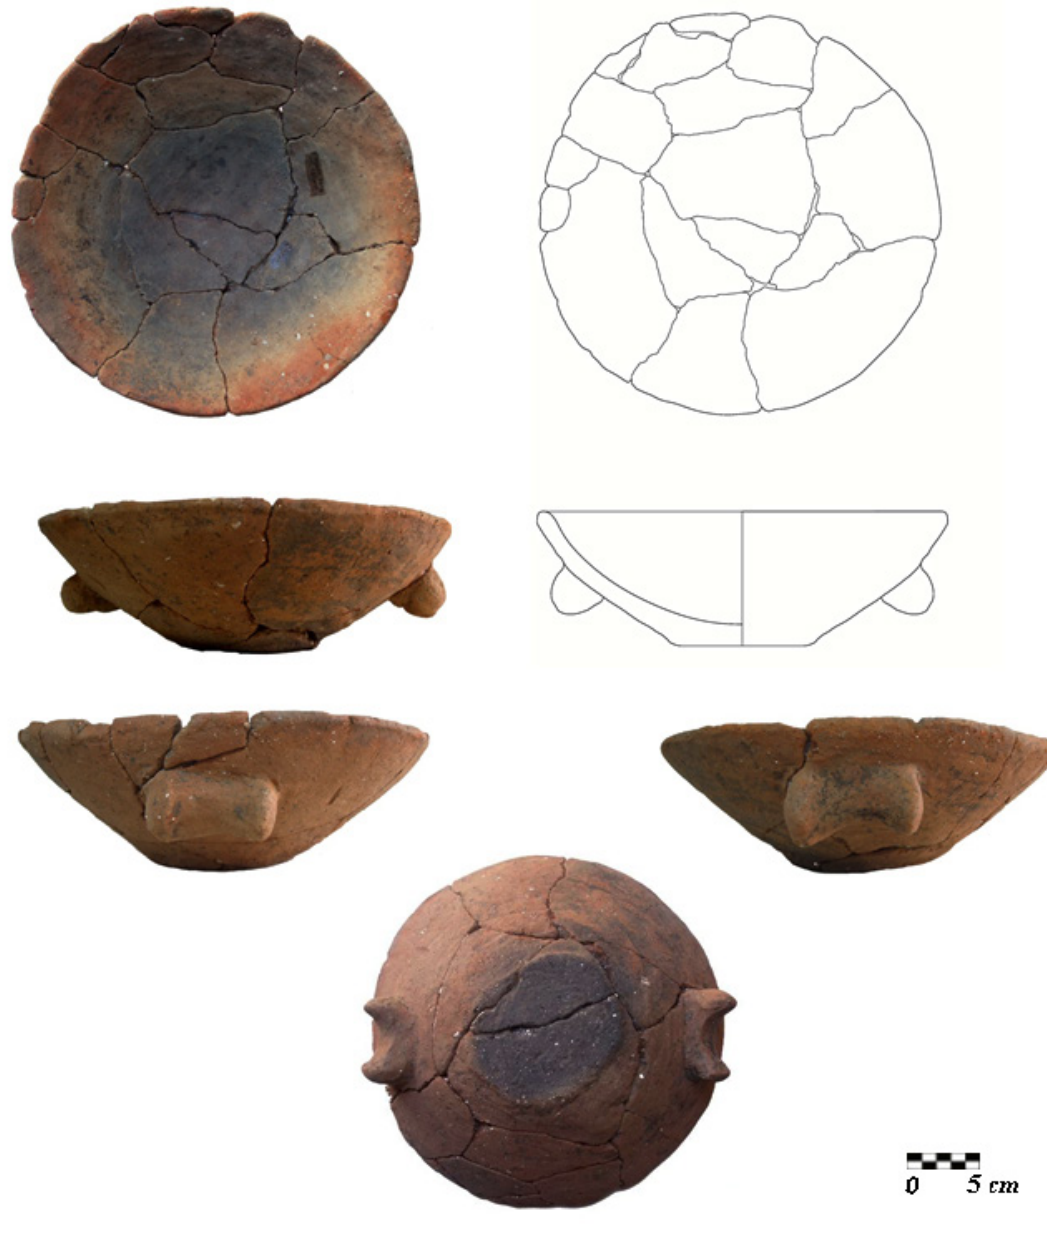
Figure 5. S. Martino. Diana pottery. Bowls with typical